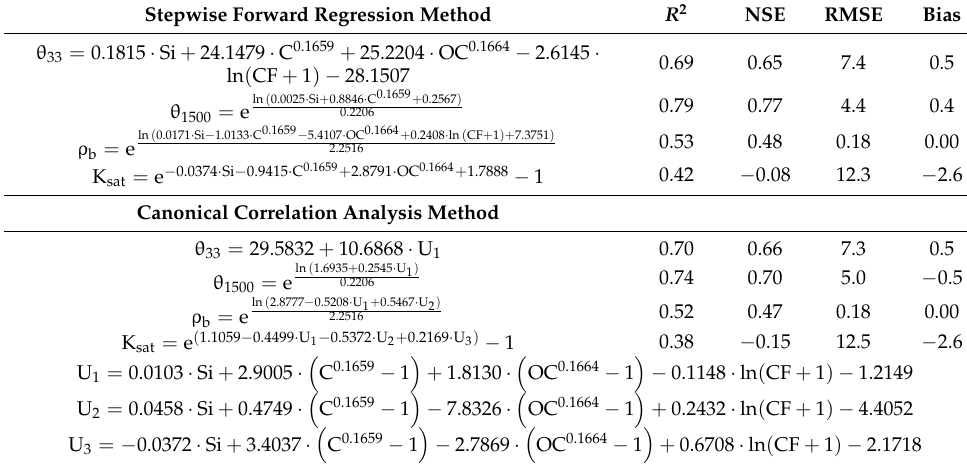
Table A3. PTFs developed for the C